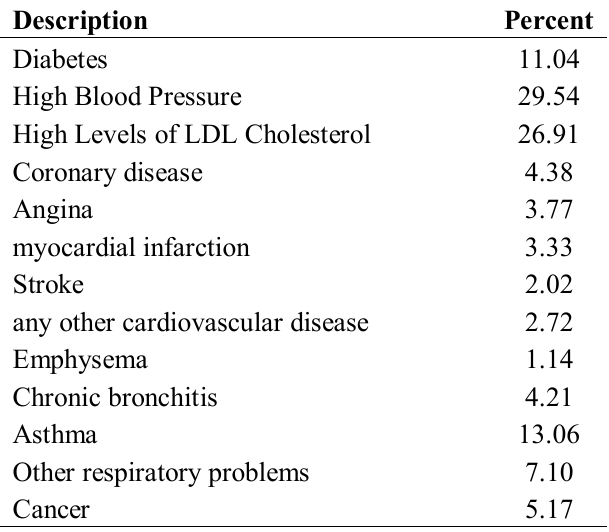
Table 2. Health conditions reported by the